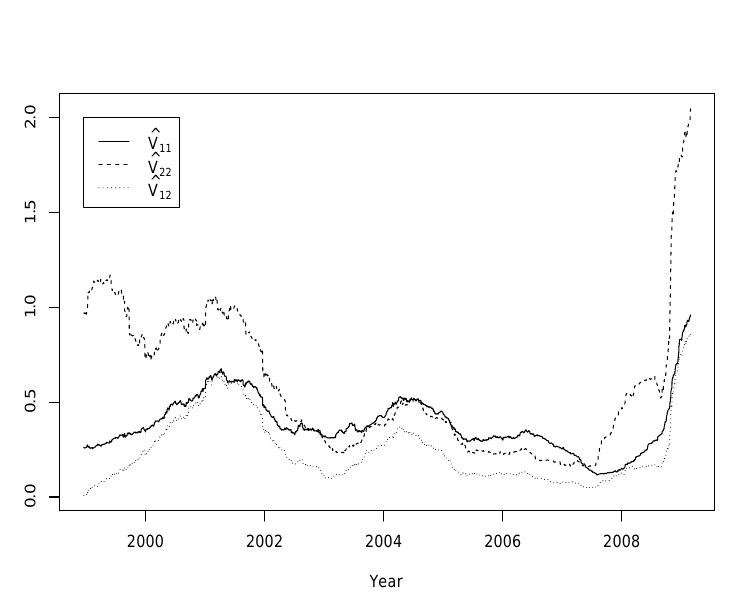
Figure 2 – The rolling estimator for the unconditional covariance matrix with the estimation win- dow of 250 days.